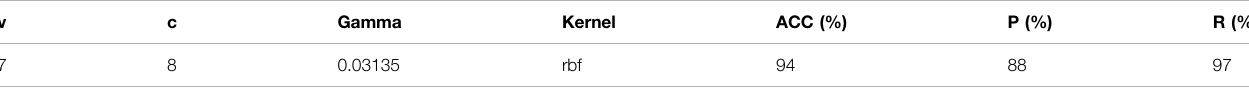
TABLE 4 | Optimal parameters and overall Performance of SVM based prediction model.